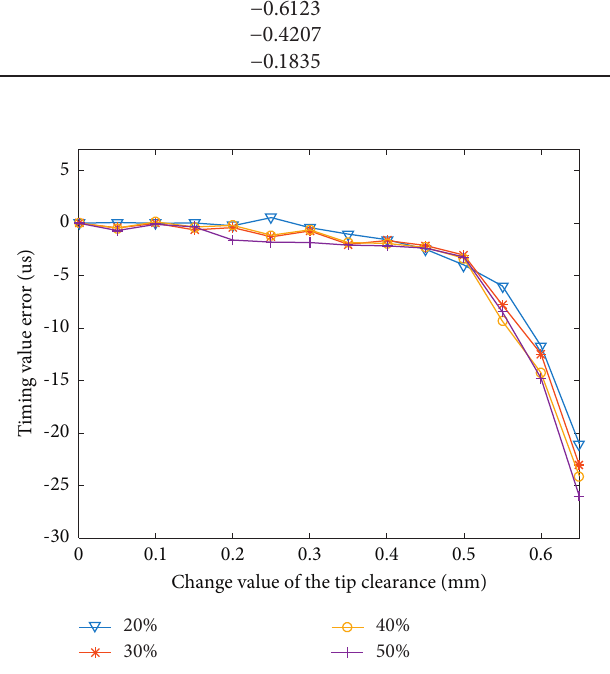
Figure 10: Timing value error comparison curves for different interception ranges.